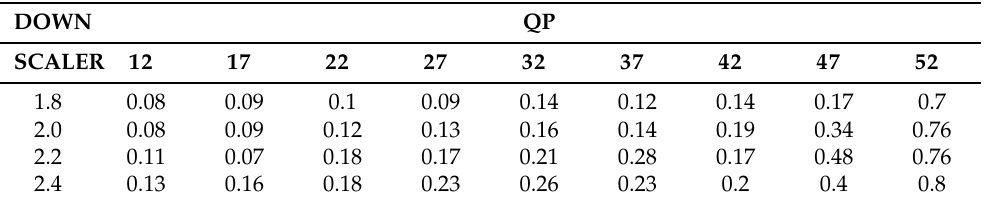
Table 2. Barcode missing rate I r (%) against QP and down scaler.